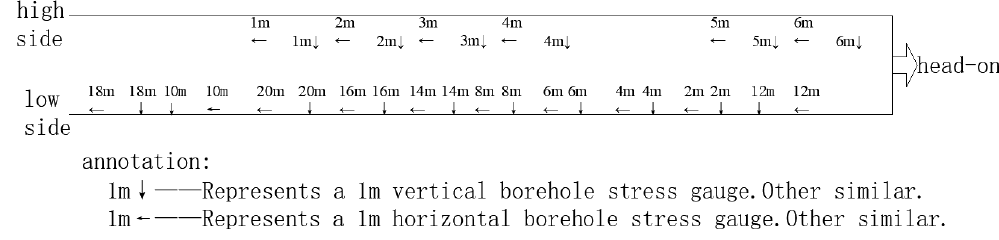
Figure 5. 12521 Schematic diagram of section layout of measuring station.